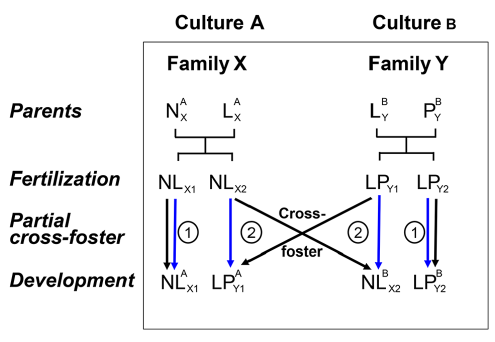
Figure 1. A cross-fostering experiment uncouples the cultural from the genetic pedigree to apportion the genetic and cultural components of behavioral traits. Note that L A and L B are siblings that were cross-fostered between cultures A and B. Superscript : cultures; subscript family of origin, plus identity of the offspring. Black arrows : genetic genealogy; Blue arrows : cultural genealogy. Cross-fostering should be performed as early in life as possible to avoid any social influence. According to this protocol, half of the offspring remain in their nests of origin (NL X1 and LP Y2 ). Their genetic (black) and cultural (blue) genealogies are thus confounded (arrows labeled 1). In contrast, for the other half of the offspring (NL X2 and LP Y1 ) the cross-fostering uncouples the genetic (black) from the cultural (blue) genealogy (arrows labeled 2). This allows us to differentiate the respective roles of genetic versus cultural inheritance in resemblance. The comparison of cross-fostered versus non-cross- fostered siblings allows the partitioning of variance between genetic and cultural effects. It is thus crucial to perform partial cross-fostering in which only some of the siblings are